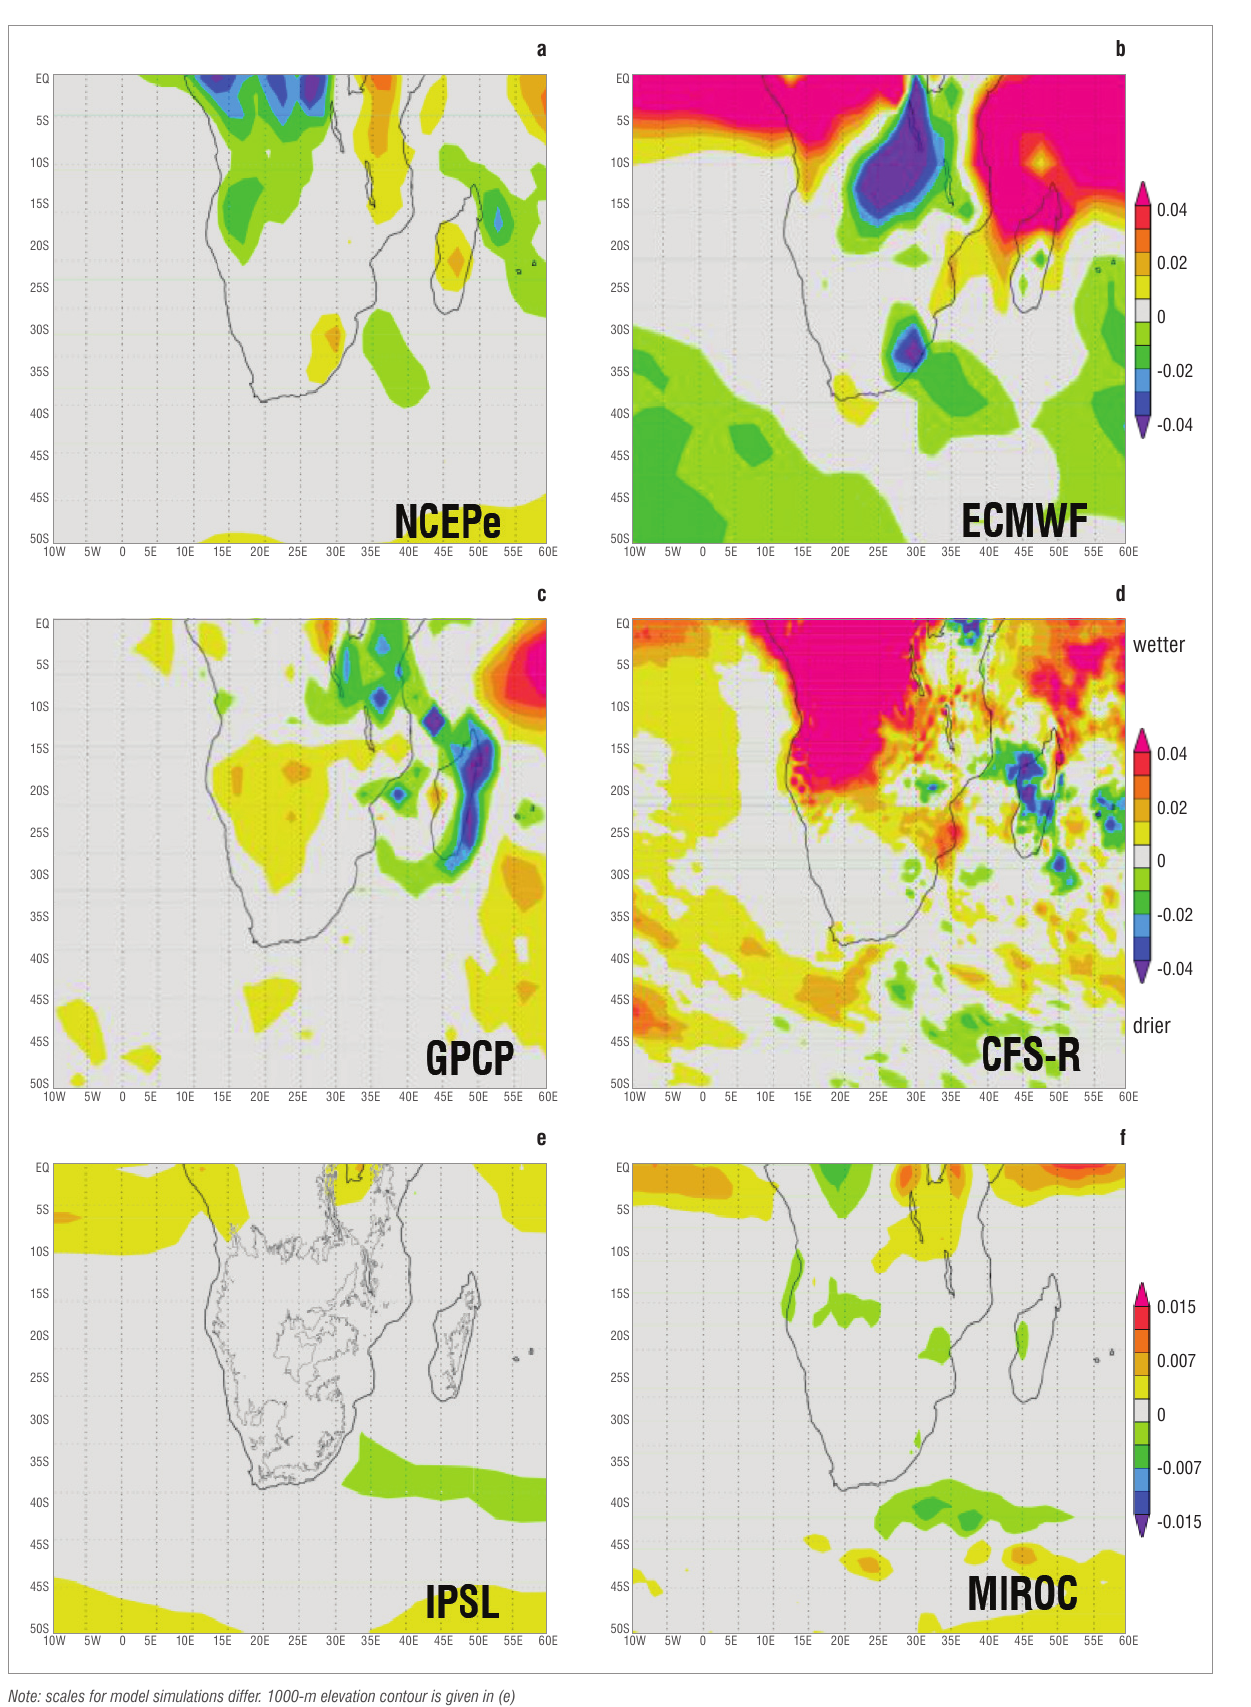
Note: scales for model simulations differ. 1000-m elevation contour is given in (e) Figure 3: Rainfall trends (mm/day per year) over southern Africa obtained through linear regression for (a) 1900–2010, (b) 1958+, (c and d) 1979+, and (e and f)